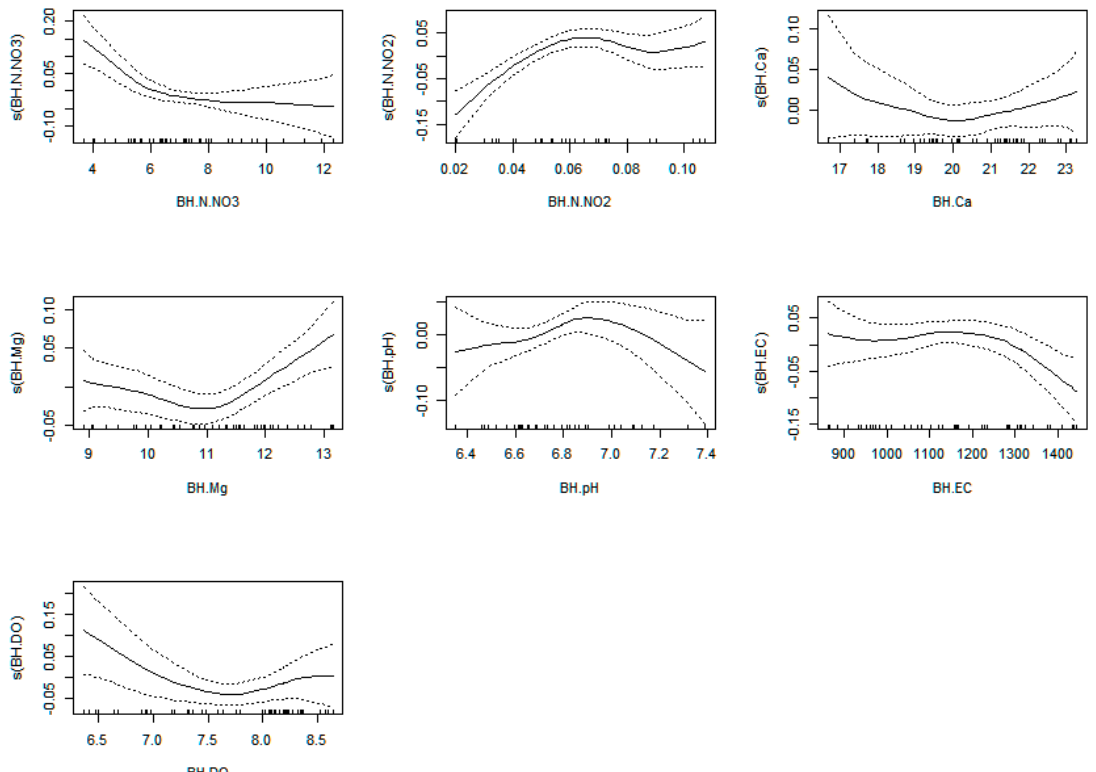
Figure A16. The GAM predictors influence over N-NH 4 for BH experimental variant.